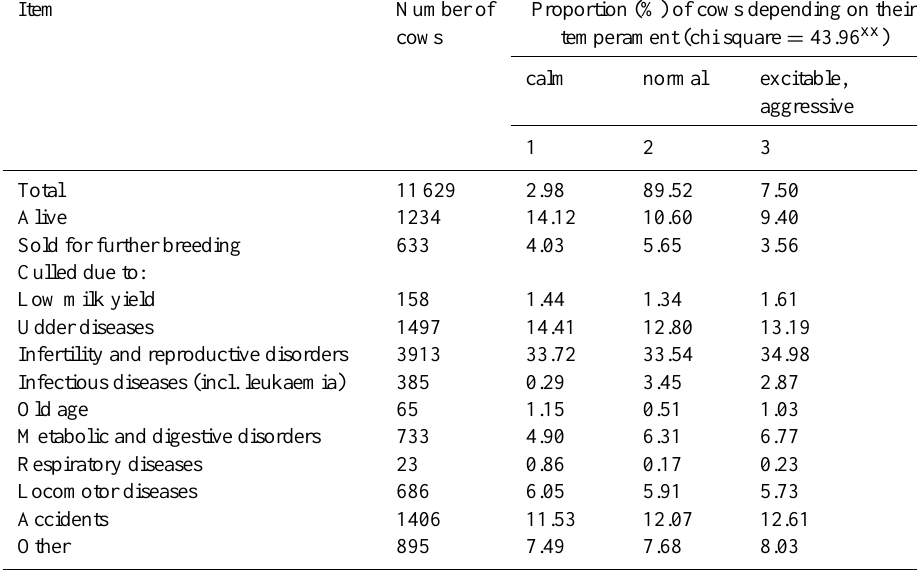
Table 3. Proportion of cows with a specific temperament (milking behaviour) over successive years of evaluation. Year Number of Proportion (%) of cows cows depending on temperament calm normal